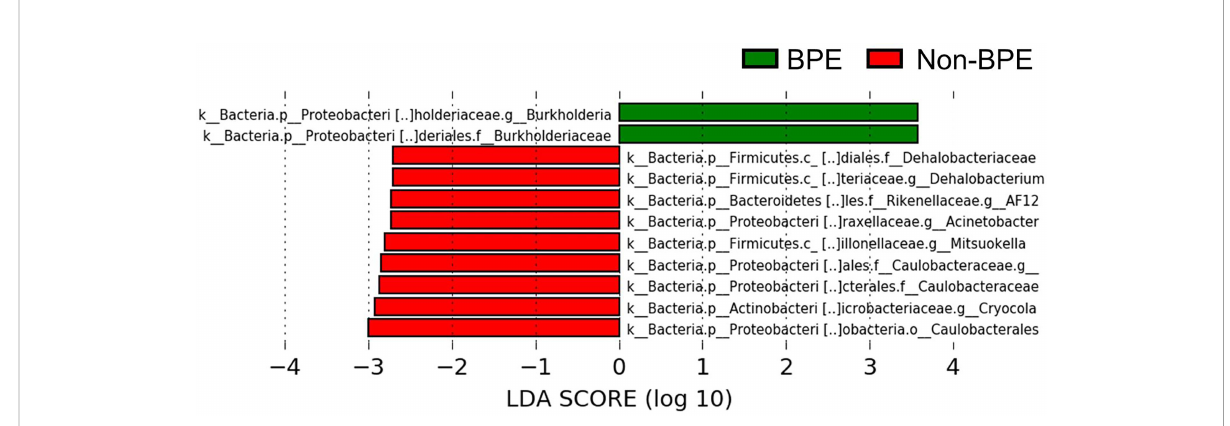
FIGURE 5 Comparison of the abundance of OTUs between the prostate microbiota of the BPE and the non-BPE groups ( P <0.05 and LDA score > |2.0|). Green bars represent OTUs positively associated with BPE group and red bars represent OTUs positively associated with non-BPE group. LDA,